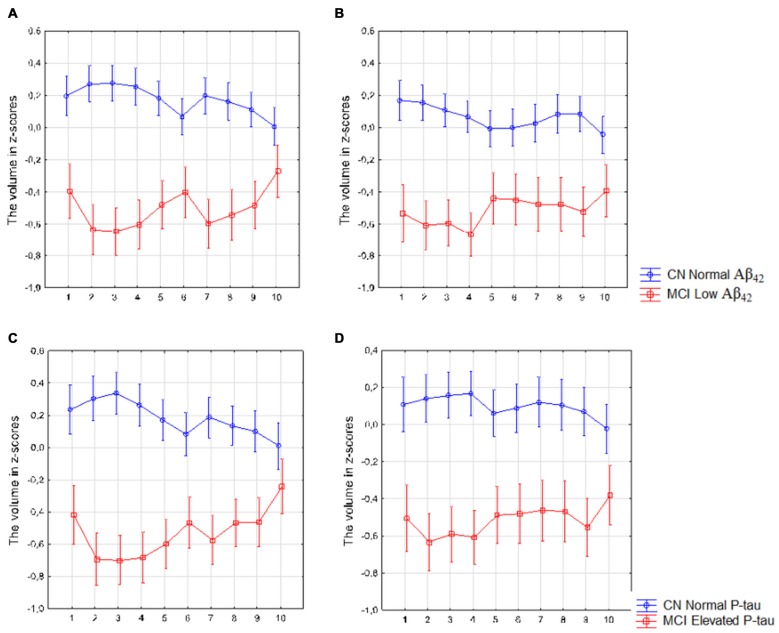
Mild cognitive impairment (MCI) with low Aβ42 or elevated P-tau levels CSF compared with controls with normal Aβ42 or P-tau levels. The figure denotes differences in subicular volume segment in MCI with abnormal (red line) and CN with normal (blue line) CSF biomarkers. (A,B) display the volume segment in left (A) and right (B) subiculum in CN without and MCI participants with low CSF Aβ42. (C,D) display the volume segment in left (C) and right (D) subiculum in CN without and MCI with elevated CSF P-tau. The x-axis denotes volume segment from posterior (segment 1) to anterior (segment 10). The y-axis denotes the volume of segment normalized as z-scores. Analysis is controlled for gender, intracranial volume and age. Vertical bars denote 95% confidence interval.